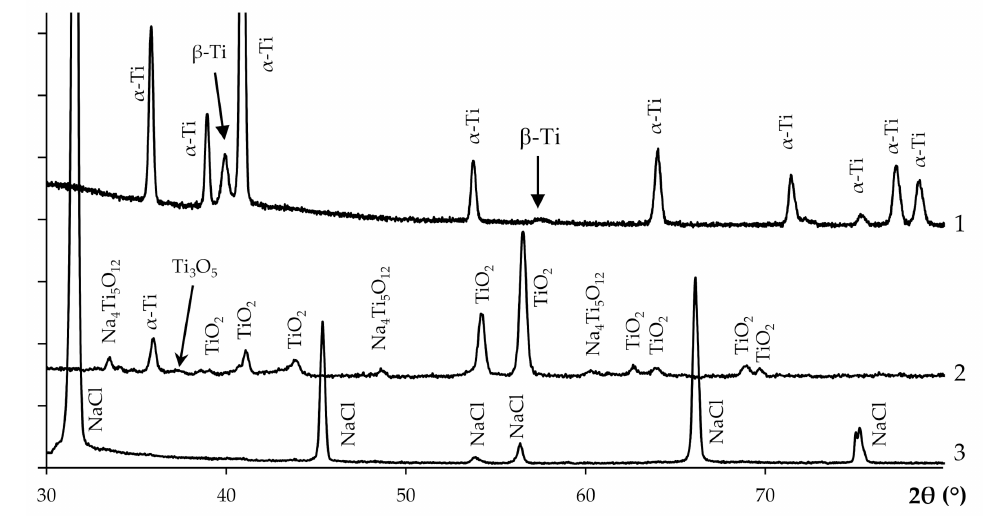
Figure 9. XRD spectra of the Ti6Al4V alloy specimen before (line (3)) and after rinsing (line (2)) in hot water. For comparison, the results of the XRD phase analysis of the Ti6Al4V alloys before HSC testing are presented in the figure (line